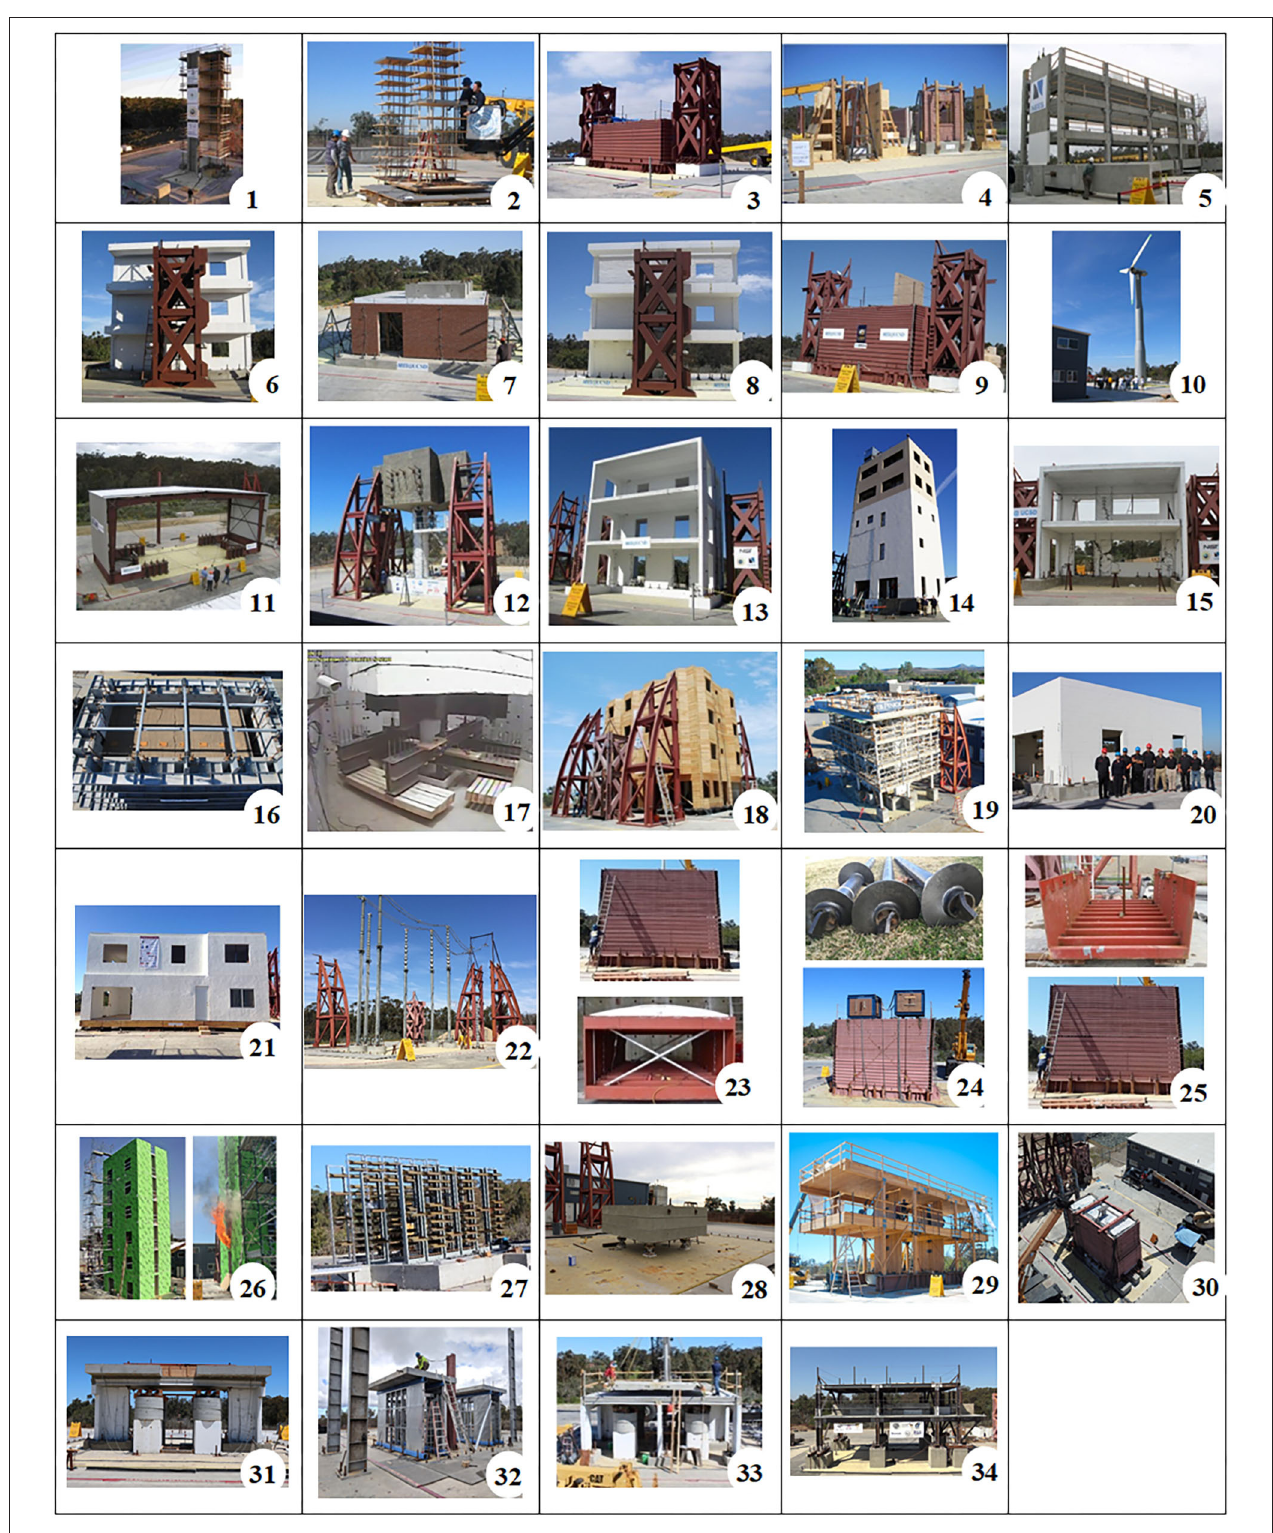
FIGURE 11 | Specimens tested on the LHPOST in the period 2004–2019.